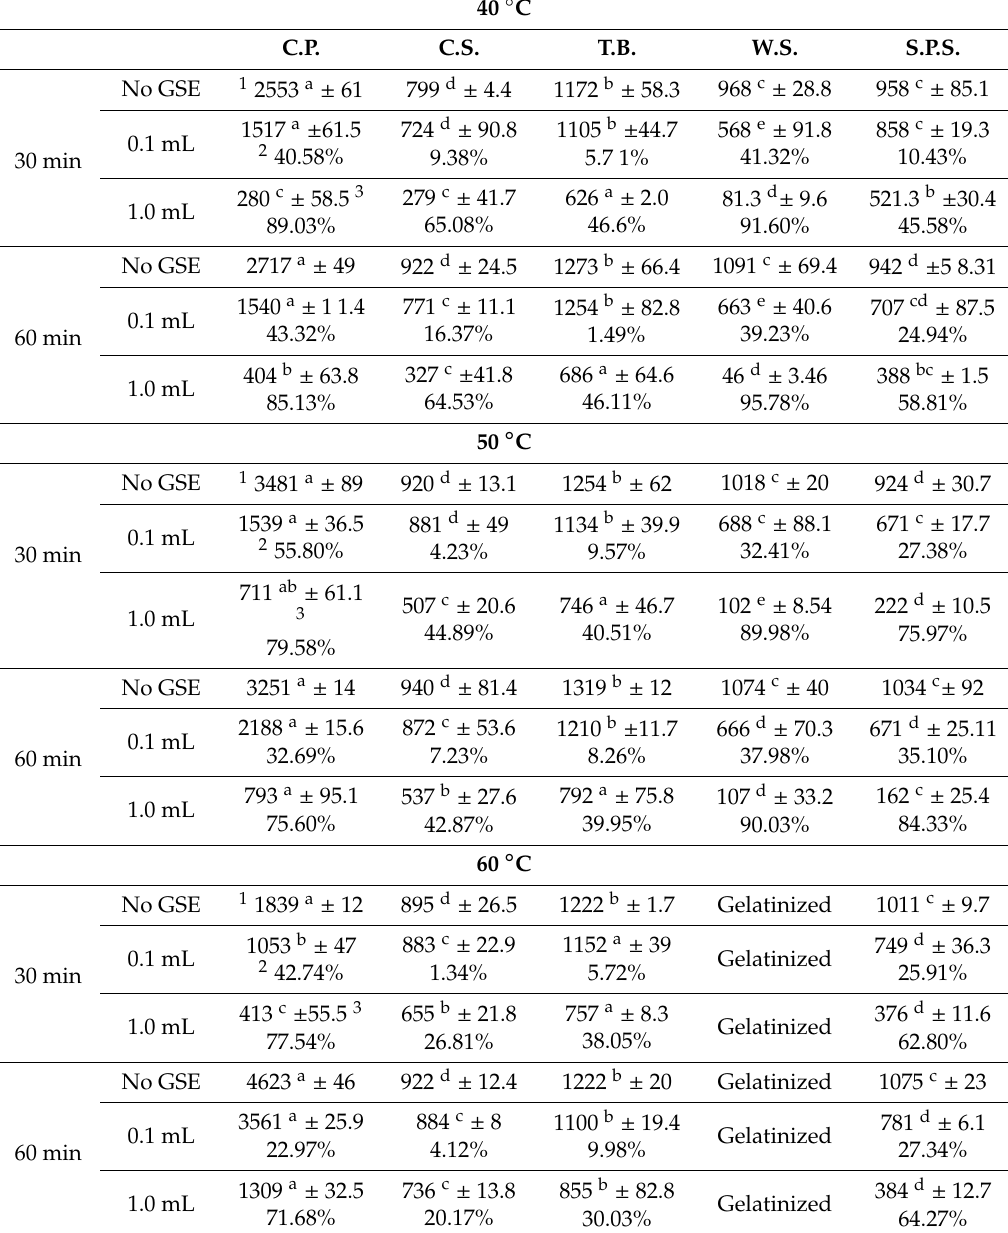
Table 2. The e ff ect of germinated sorghum extract (GSE) on the setback (cP) of starches annealed at 40, 50, and 60 ◦